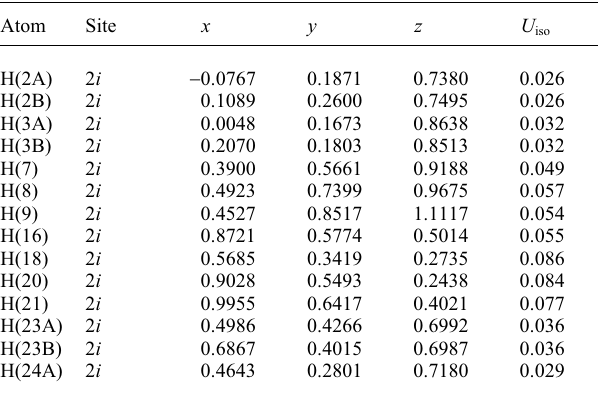
Table 2. Atomic coordinates and displacement parameters (in Å 2 )